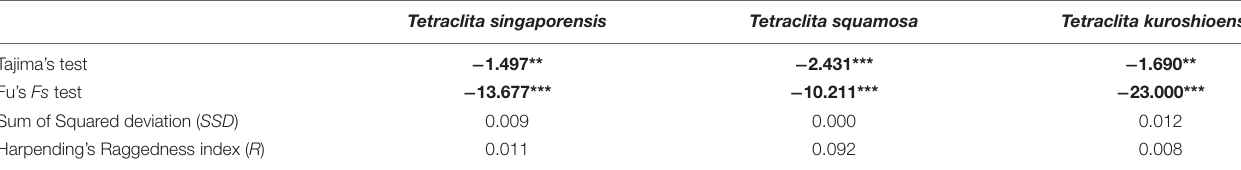
FIGURE 3 | Mismatch distribution (A–C) and haplotype network (D–F) from CO1 and 12S rRNA concatenated sequences of Tetraclita spp. The results of mismatch distribution are shown in the histograms. The abscissa indicates the number of pairwise difference between specimens, and the ordinate indicates the frequency of each value. The colored and gray bars represent the frequency distribution of the observed and expected pairwise difference, respectively, under the sudden expansion model. For the haplotype network, the size of each circle represents the number of specimens. The haplotype numbers are shown in each circle, and details on each haplotype can be found in Supplementary Table 1 . TABLE 4 | Demographic parameters under the sudden expansion model of Tetraclita in